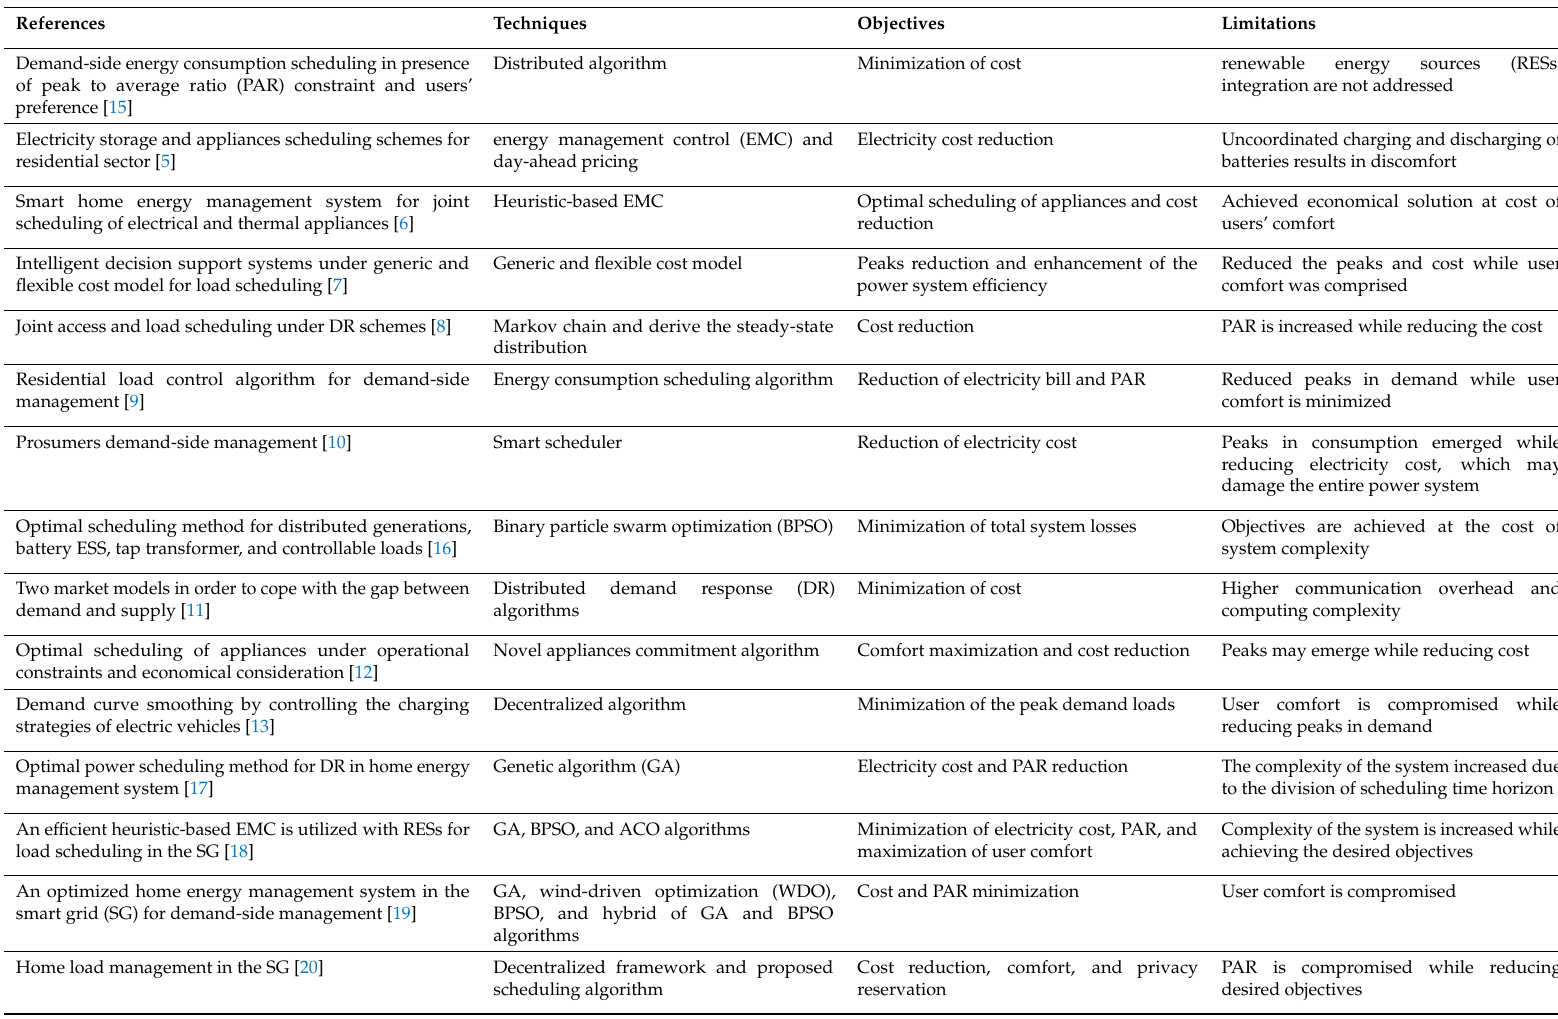
Table 1. Summary of related